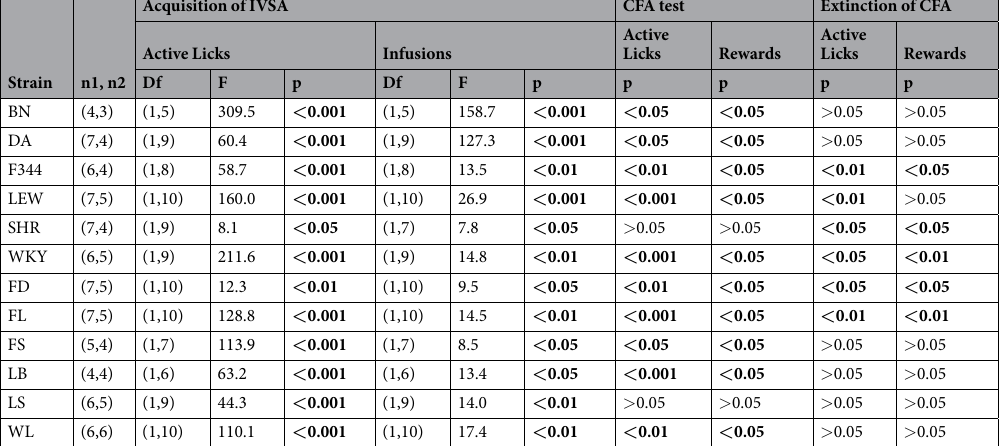
Table 4. Effect of nicotine on the acquisition of socially acquired nicotine IVSA, CFA, and extinction of CFA. Two groups of rats received i.v saline or nicotine with contingent flavor cue in the abscence of demonstrator rats for each strain. n1 and n2 are the number of animals used for the nicotine and saline groups, respectively. The number of licks on the active spout and infusions were compared between the two treatment groups (i.e., nicotine vs saline) for each strain using two-way repeated measures ANOVA. These rats then were tested for CFA during the fourth session (i.e. CFA test). CFA tests continued for a total of five daily sessions and the data on the last session were used to evaluate the extinction of CFA. Two-tailed independ t-tests were used to compare the effect of treatment on CFA and extinction of